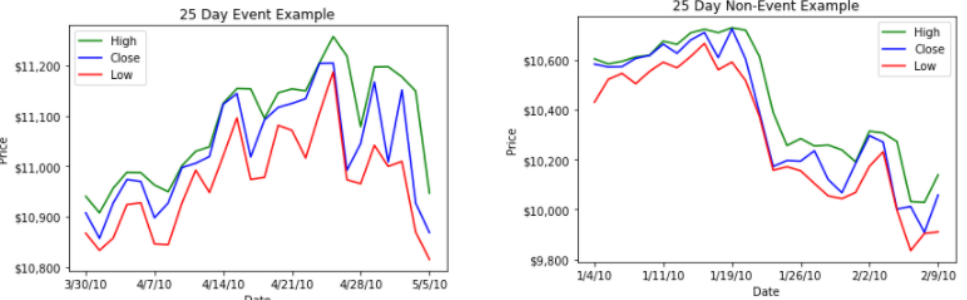
Figure 2. Examples of line graphs that show 25 days leading up to an event and non-event.